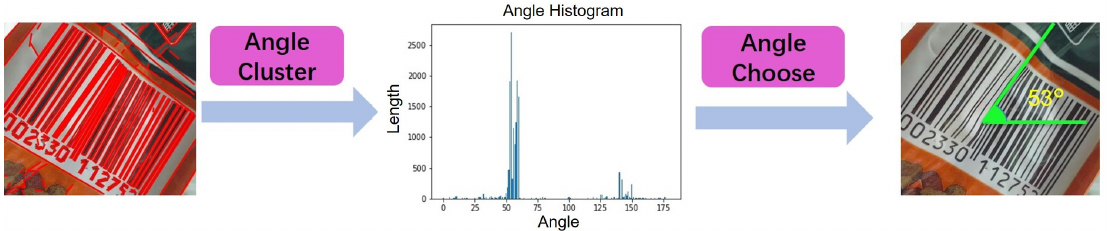
Figure 2. Angle prediction in the bounding box region: We detect all the line segments in the bounding box region, and calculate the angle and length of every line segment using the endpoints. Then, we cluster all the line segments and summarize the length in every degree. As the clustering result shows in the angle histogram, 53 ◦ is the maximum length value, which will be chosen as the rotation